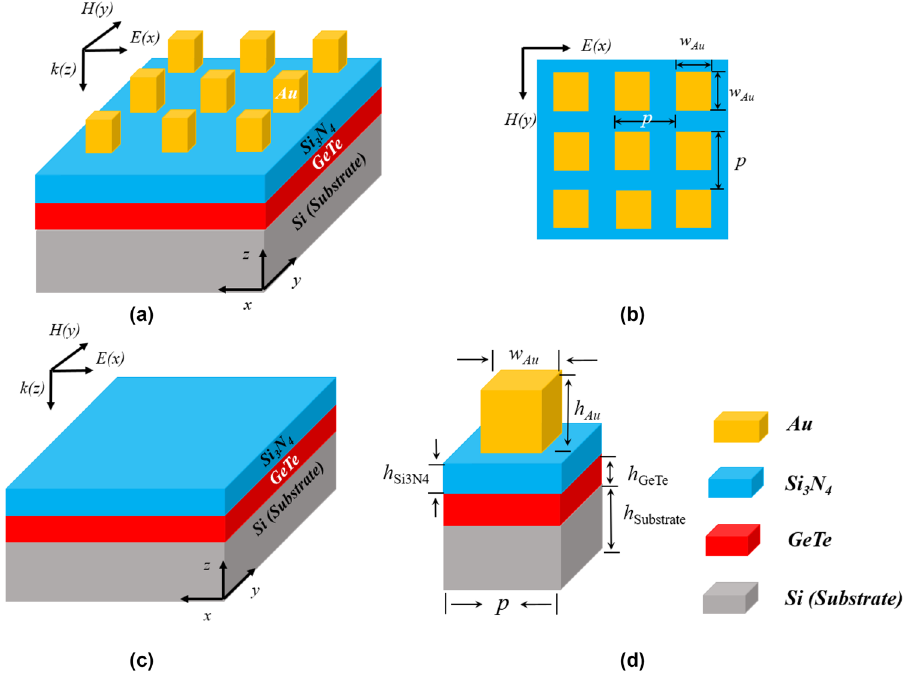
Figure 1. ( a ) Schematic representation of the hybrid absorber; ( b ) top view of the absorber the hybrid plasmonic absorber; ( c ) representation of the planar control absorber without Au nanoantennas; ( d ) unit cell of the hybrid plasmonic absorber.